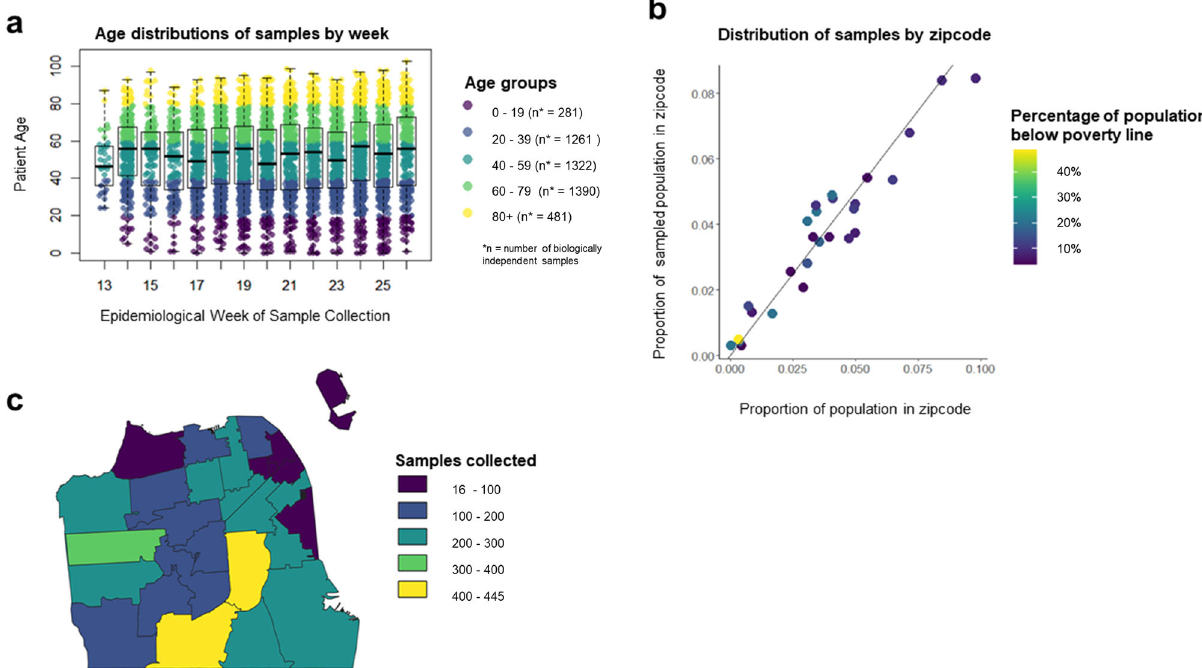
Fig. 2 Distributions of SCALE-IT samples. Figure showing distributions of SCALE-IT samples a boxplot showing the distribution of samples by epidemiological week and age group (whiskers show minimum and maximum age, box shows 0.25 quantile, median and 0.75 quantile age respectively) b plot of the proportion of the samples collected from patients residing in a zip code, plotted against the actual proportion of the San Francisco population living in that zip code. Colors show the proportion of the population in that zip code living below the poverty line using the 2018 American Community Survey thresholds, and c map of counts of samples collected by zip